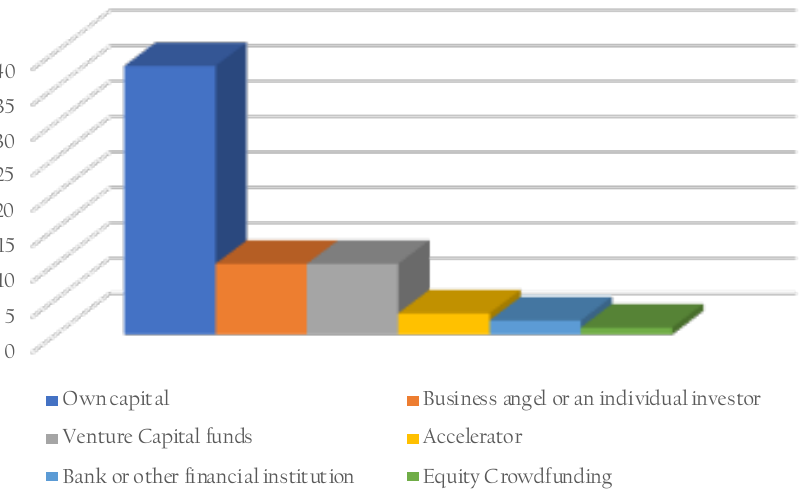
Figure 11. Sources of capital for Polish